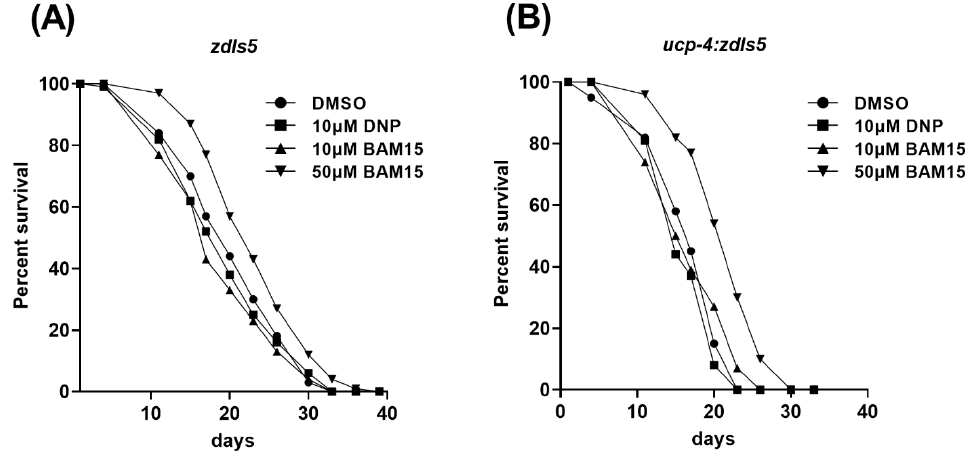
Figure 4. BAM15 extends the mean lifespan in C. elegans . ( A , B ) Kaplan–Meier survival curves of zdIs5 ( A ) and ucp-4 ; zdIs5 ( B ) treated with 10 µM DNP, 10 µM BAM15, and 50 µM BAM15. n = 248~309 per treatment in each genotype. Log-rank test, p < 0.001 between DMSO and 10 µM DNP, and DMSO and 50 µM BAM15 treatments. Data are presented as means of three independent experiments.